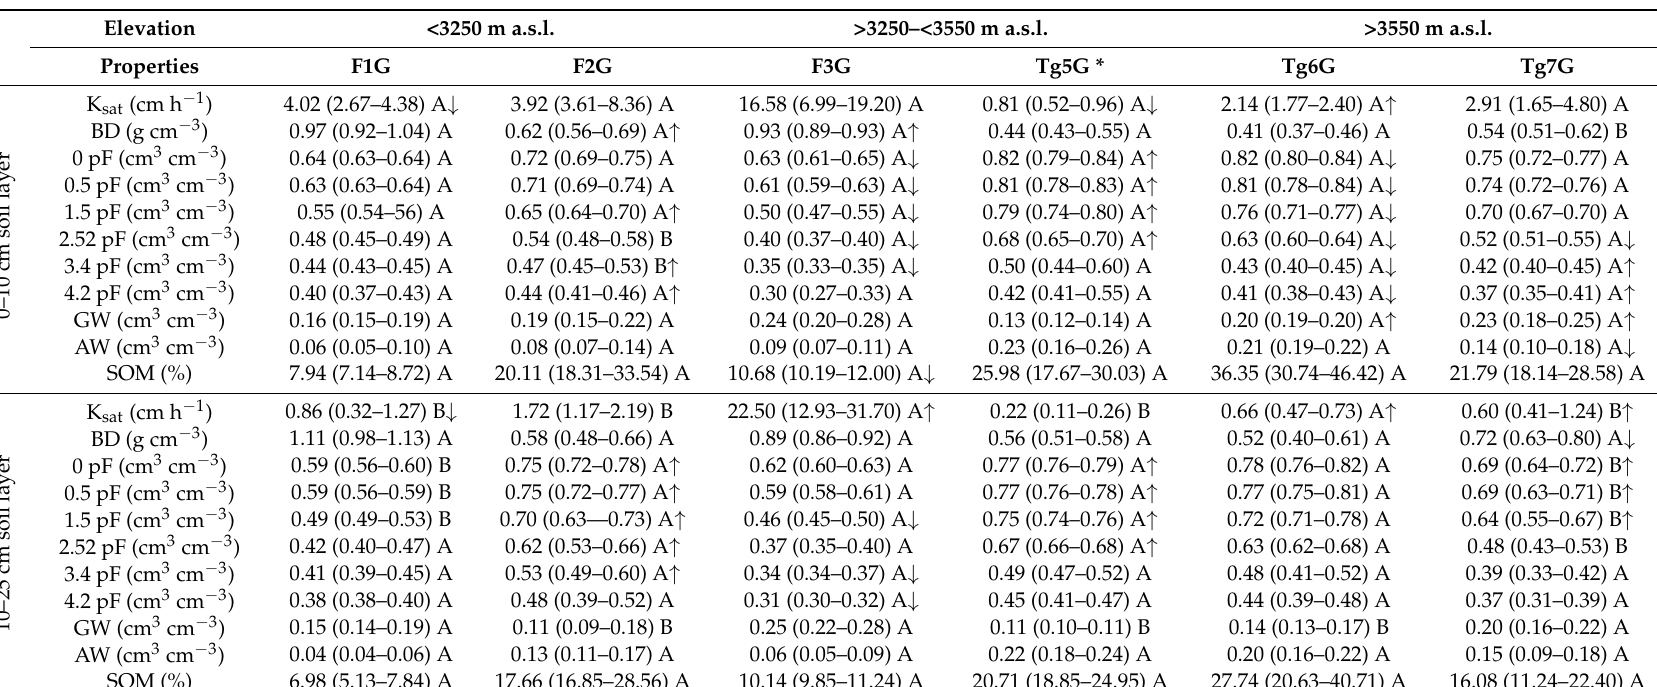
Table A3. Median and the 25th and 75th percentile of the hydro-physical properties and SOM content of the soil in the high montane forest and p á ramo under cattle grazing (F = high montane forest; Tg = p á